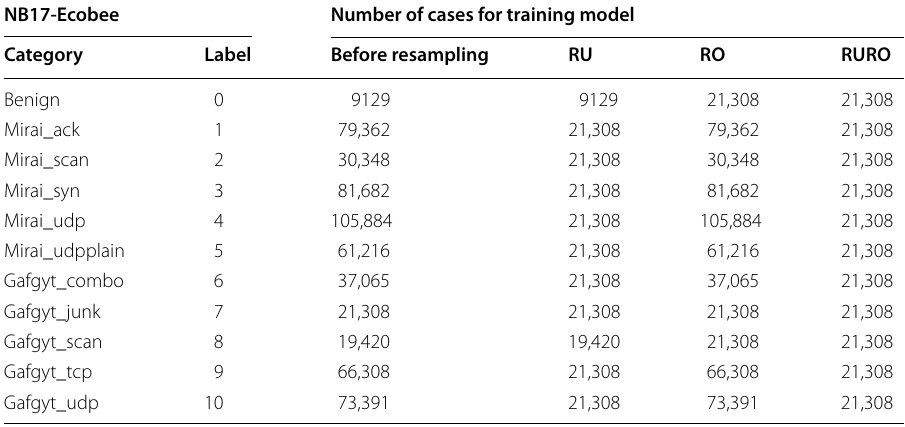
Table 37 Resampling of